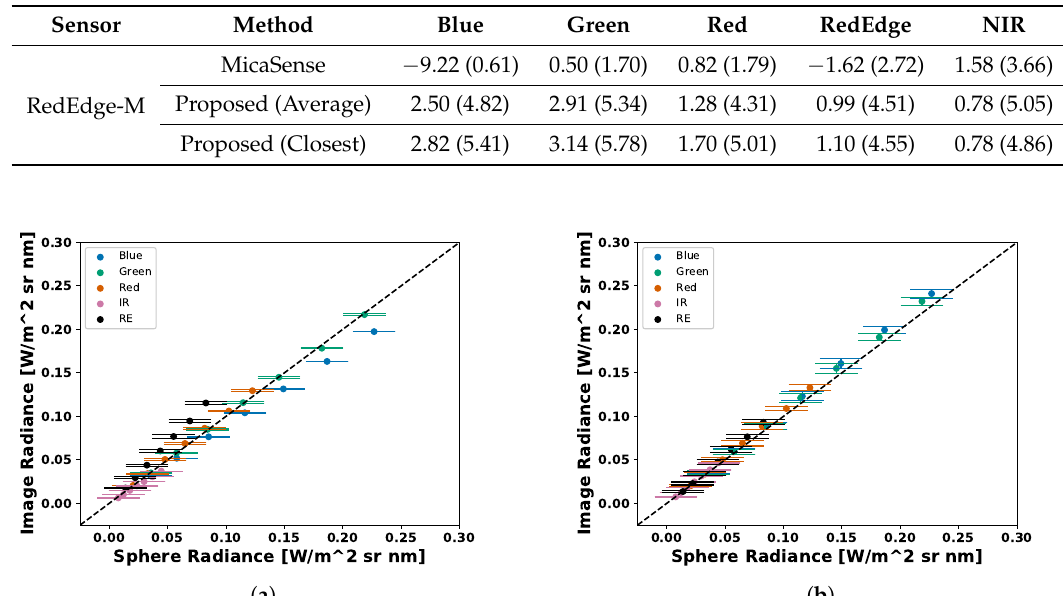
Table 5. Average percent errors in radiance imagery for all bands using both conversion methods for the RedEdge-M. Standard deviations are shown in parenthesis.